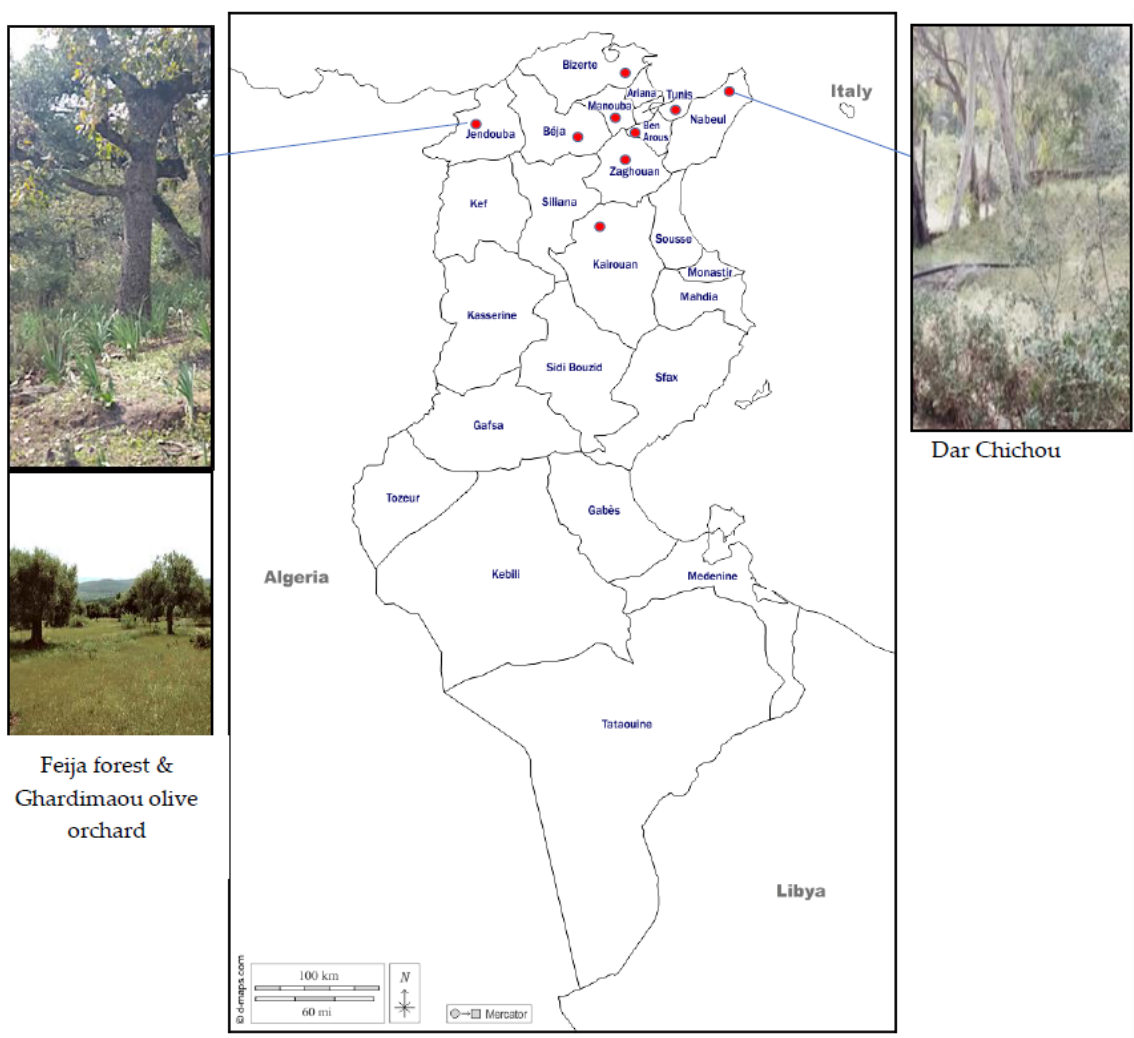
Figure 1. Spittlebug collecting regions (red circles) in Tunisia with focus on two reservoir forests: Dar Chichou and Feija.